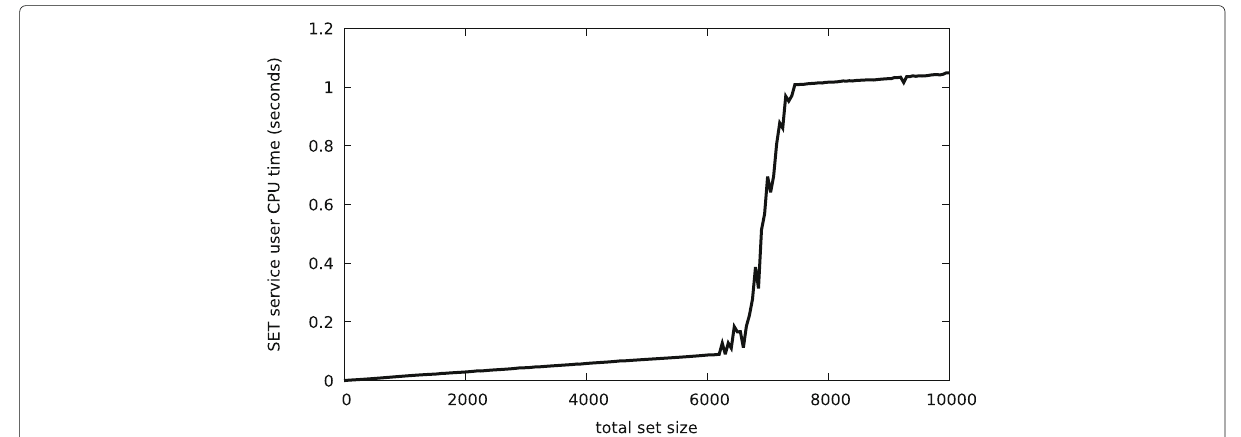
Fig. 1 CPU system time for the SET service in relation to total set size. Average over 50